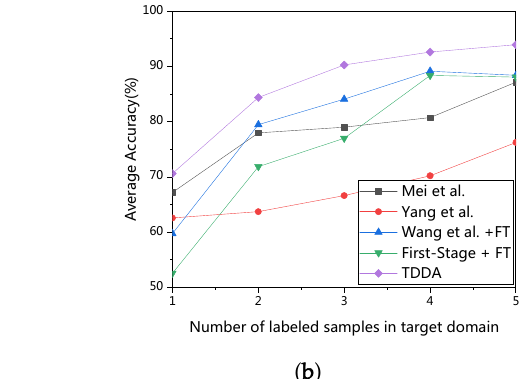
Figure 10. The classification results of different methods with different labeled samples in target domain on Pavia University → Pavia Center dataset. ( a ) OA. ( b ) AA.